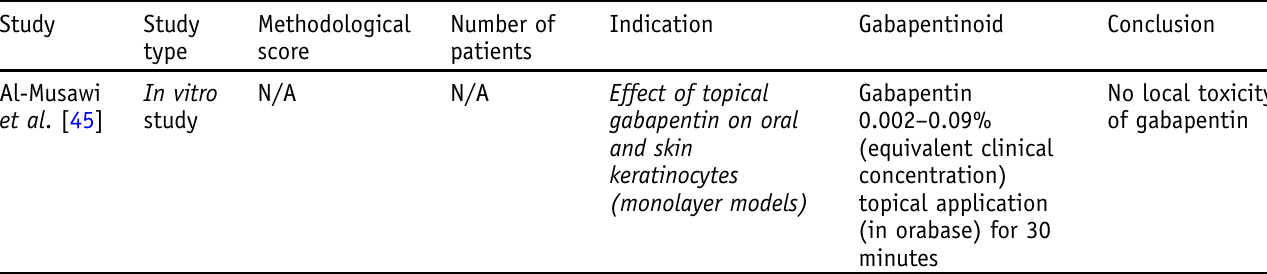
Fig. 4. Untoward effects of gabapentinoids reported in the scoping review. Table IV. Scoping review results (cid:1) Gabapentinoid